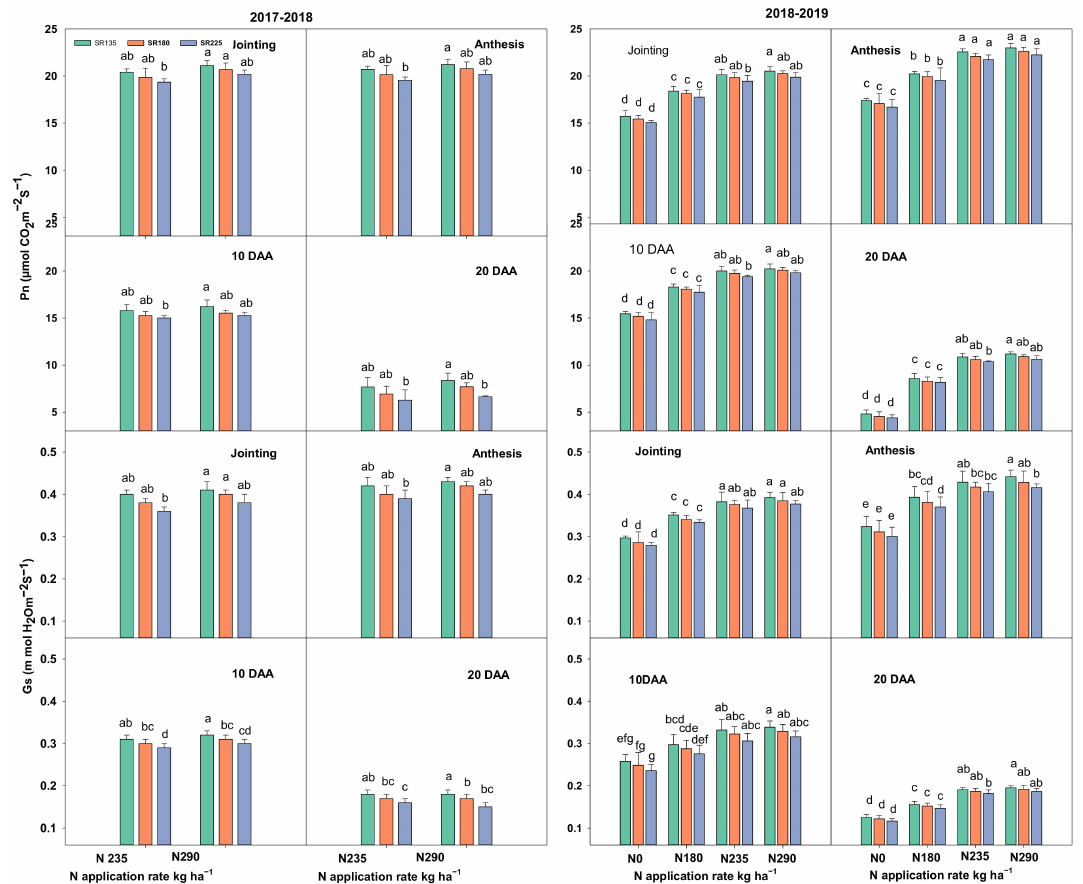
Figure 1. Effects of the combination of N and SR on photosynthesis (Pn) and stomatal conductance (Gs) during four differnet growing stages in 2017–2018 and 2018–2019. Different letters repre- sent significant differences in mean values of three replicate plots at p ≤ 0.05 levels according to Duncan’s test.